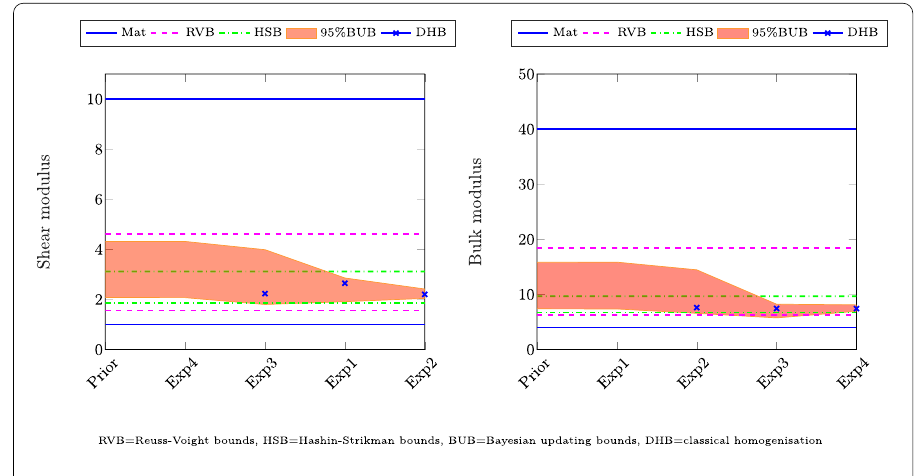
Fig. 4 Upscaling of deterministic material properties: a shear modulus [MPa] b bulk modulus [MPa]